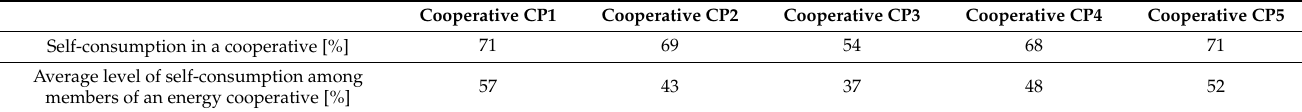
Table 4. Energy self-consumption at the level of the energy cooperative and the individual members. Cooperative CP1 Cooperative CP2 Cooperative CP3 Cooperative CP4 Cooperative CP5